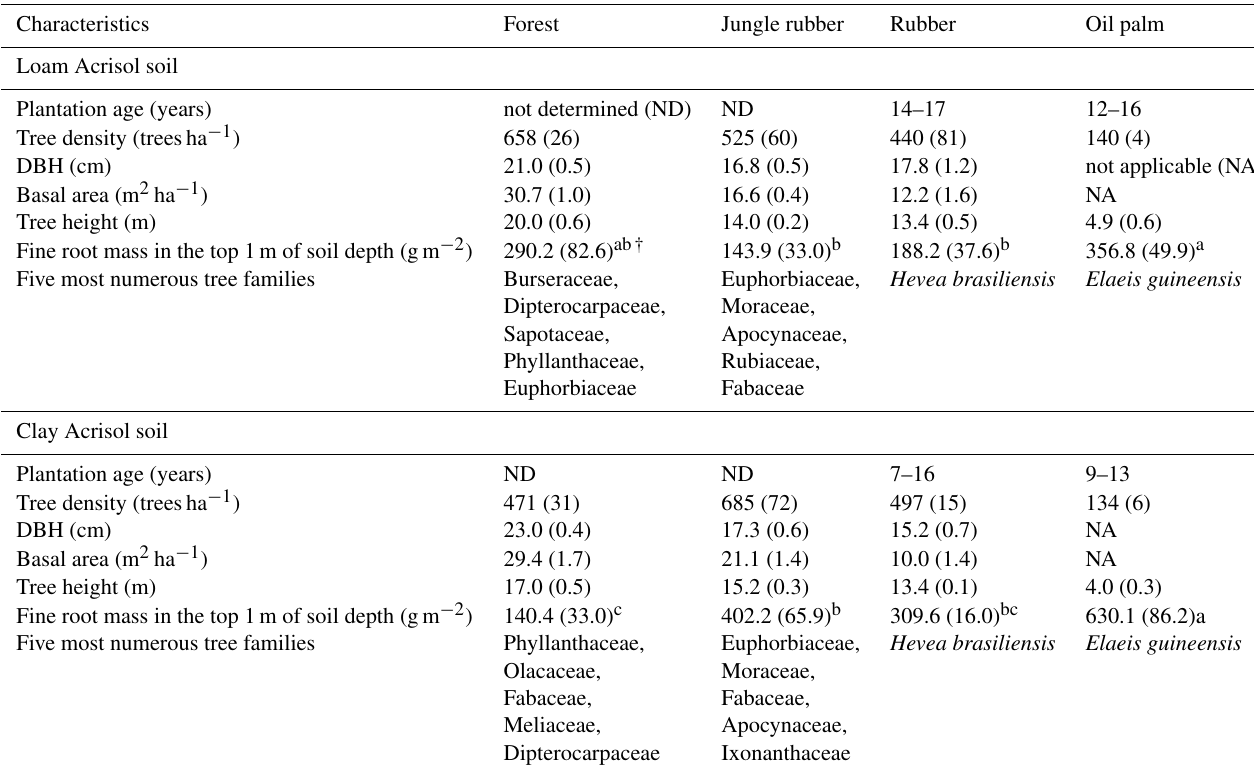
Table A2. Mean ( ± SE, n = 4) tree density, diameter at breast height (DBH), basal area, height, cumulative fine root mass in the top 1m of depth, and the most common tree species with DBH ≥ 0.10m in different land uses within the loam and clay Acrisol soils in Jambi, Sumatra, Indonesia. The vegetation characteristics (e.g., tree density, DBH, basal area, and height) were reported by Kotowska et al. (2015); the five most numerous tree families with DBH ≥ 0.10m are based on Rembold et al. (2017) and Rembold (Katja Rembold, personal communication, 2018). The fine root mass in the top 1m of soil depth was measured in our present study. Means of fine root mass followed by different lowercase letters indicate significant differences among land uses within each soil type (one-way ANOVA with Fisher’s LSD test at P ≤ 0 . 05 and † at P ≤ 0 . 09 for marginal